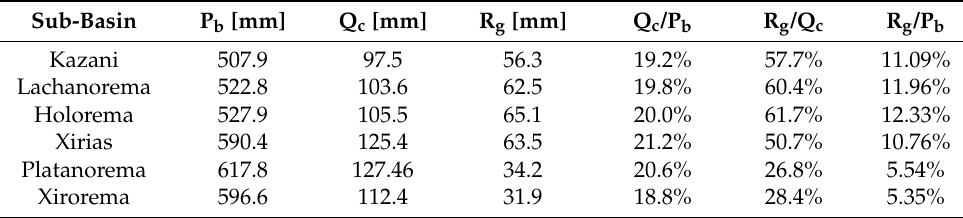
Table 6. Mean annual statistics of precipitation (P b ), surface runoff (Q c ), and groundwater recharge (R g ) per sub-basin for the period of October 1961 to September